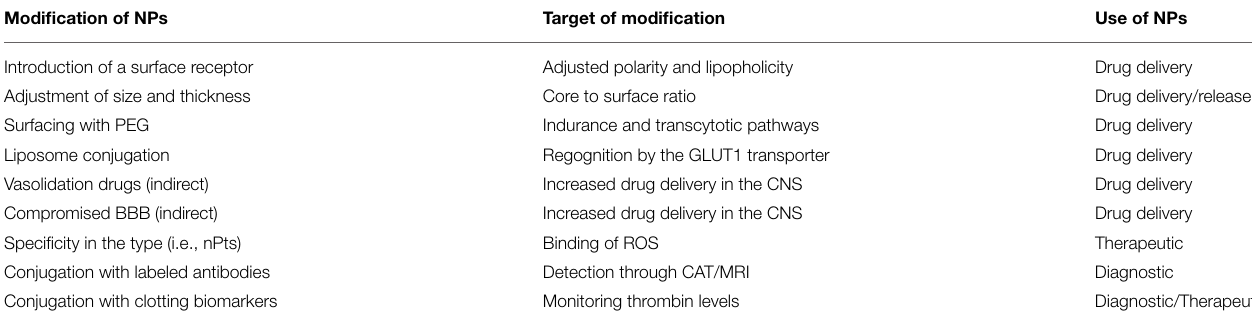
TABLE 1 | Modification of nanoparticles (NPs) to improve specificity against the central Nervous System